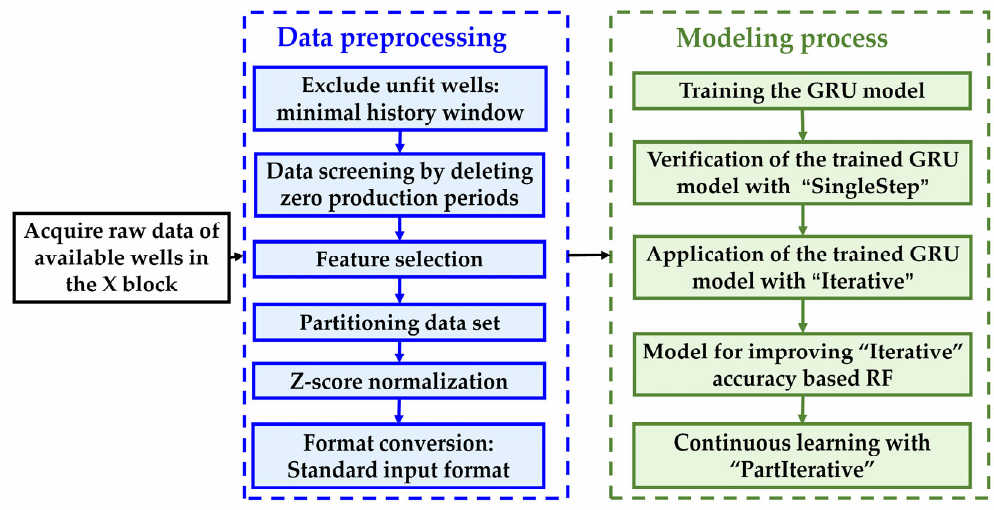
Figure 2. Workflow of data preprocessing and model analysis.